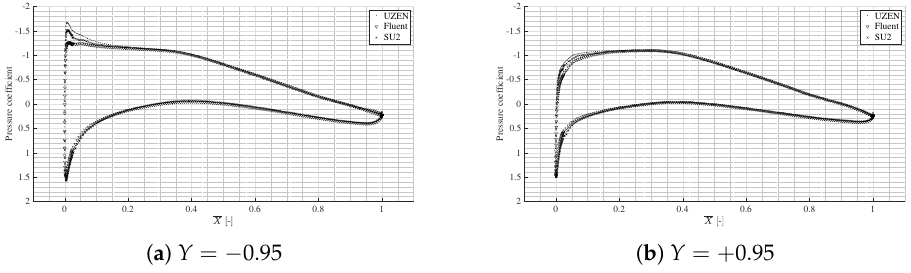
Figure 17. Pressure coefficient at α = 4 ◦ . Code-to-code